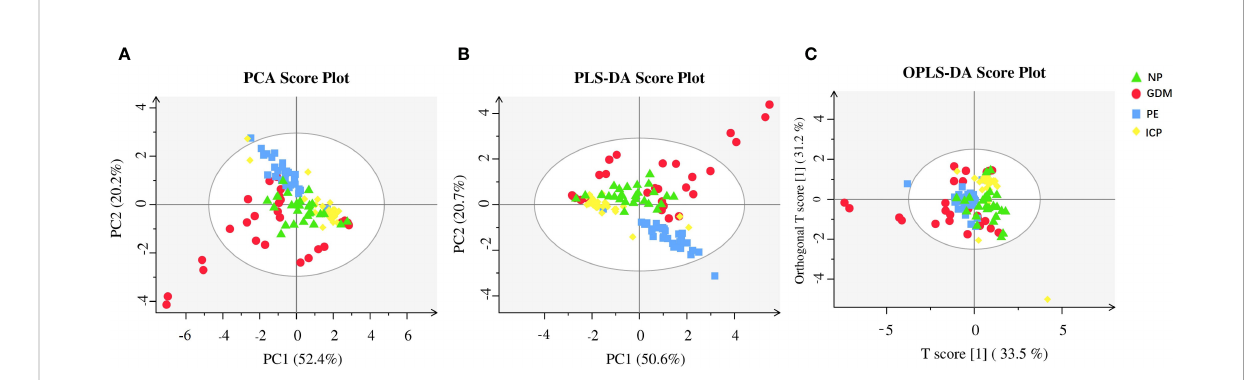
FIGURE 1 Metabolic analysis of SCFAs in pregnancy complications and NP groups. (A) PCA; (B) PLS-DA; (C) OPLS-DA. The abscissa is the fi rst principal component (PC1), the ordinate is the second principal component (PC2), and the numbers in parentheses represent the proportion of the corresponding principal components in the comprehensive original information. One point in the fi gure corresponds to one sample, green represents the NP group, red represents the GDM group, blue represents the PE group, and yellow represents the ICP group.